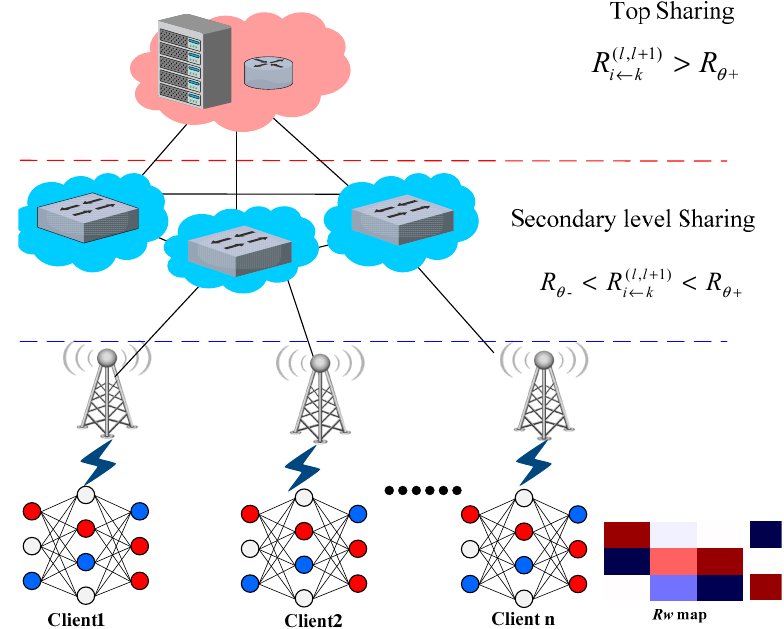
Figure 6. Diagram of federated learning framework based on network interpretable parameters.